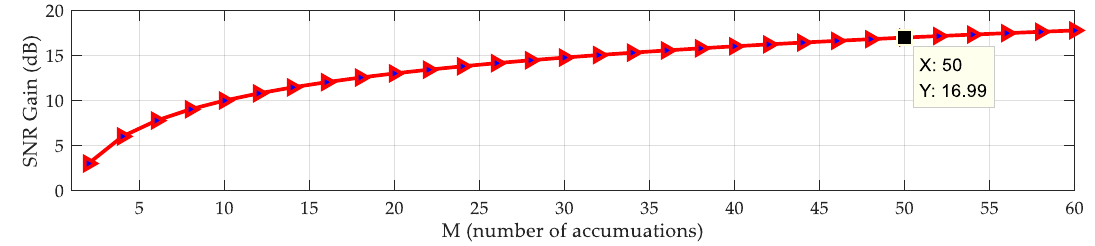
Figure 7. Signal-to-noise ratio (SNR) gain as a function of the number of